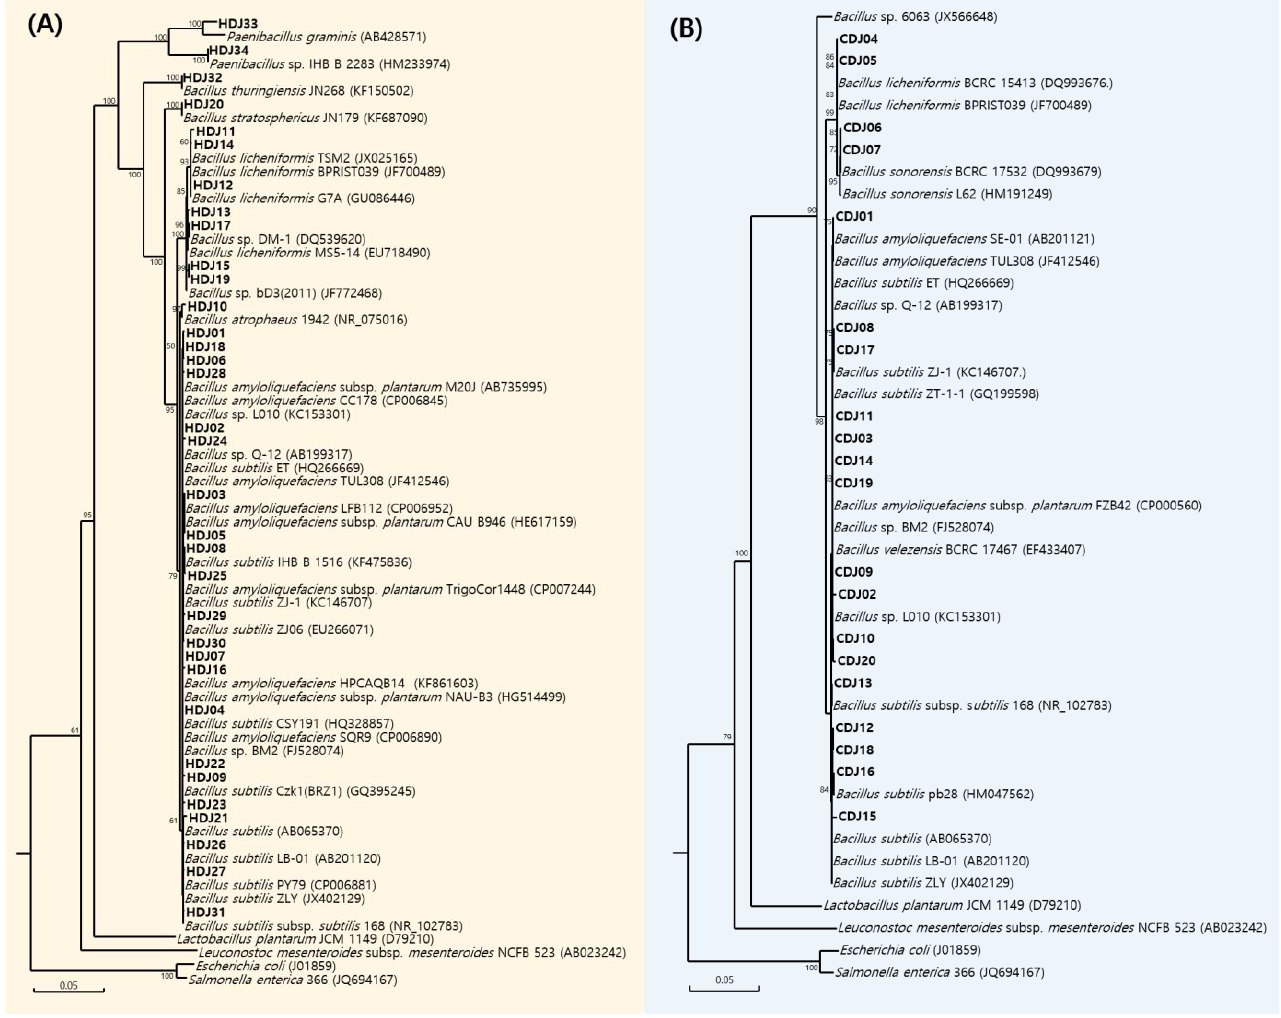
Figure 1. Phylogenetic placement of 16S rRNA sequences of isolates from household and commercial doenjang . ( A ) household doenjang (HDJ); and ( B ) commercial doenjang (CDJ). Numbers above each node are confidence levels (%) generated from 1000 bootstrap trees. The scale bar is in fixed nucleotide substitutions per sequence position.